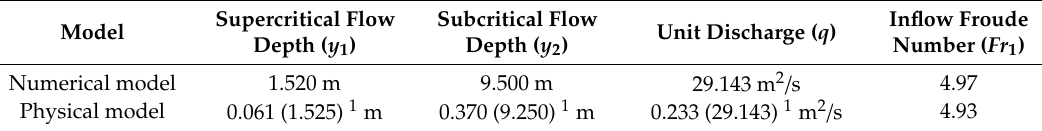
Table 3. Basic flow variables for the numerical and physical